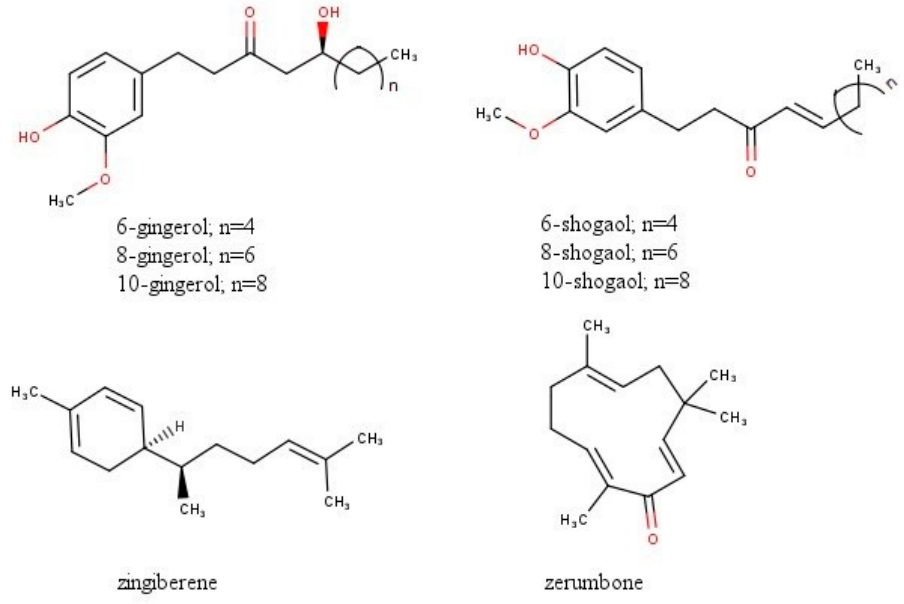
Figure 1. Chemical structures of the main components of Ginger. Gingerols and 6-shogaol possess anti-inflammatory and antioxidant activities, which contribute to renal [16,17], hepatoprotective [18,19], and neuroprotective [20] effects, as well as improvement in the symptomatology of ulcerative colitis [21]. Shogaol but not gingerol possesses neuroprotective activities against hemorrhagic brain injury [22] and multiple sclerosis [23]. Additionally, it diminished the formation of amyloid beta in ani- mal brains and prevented memory impairment by reducing microgliosis and astrogliosis and enhancing the levels of nerve growth factor and synaptogenesis in the brain [24].